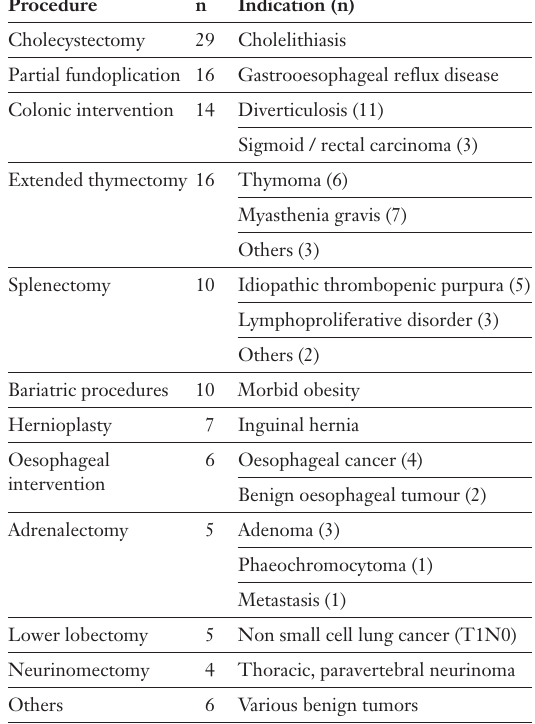
Robotic procedures: numbers and indica- tions.